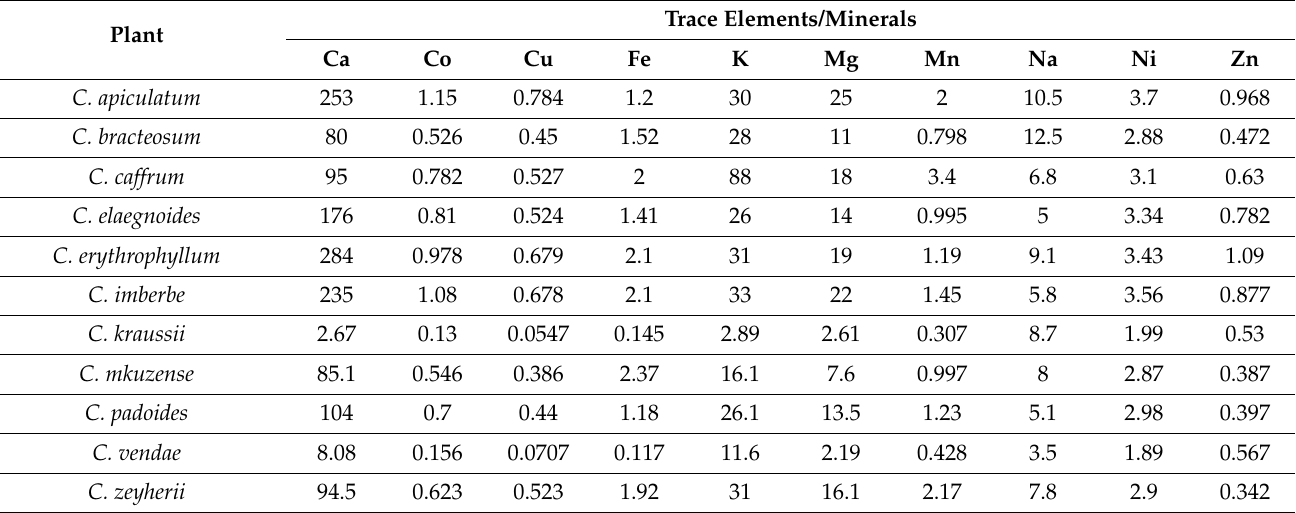
Table 6. Concentration (mg/mL) of trace minerals in the stem of some Combretum